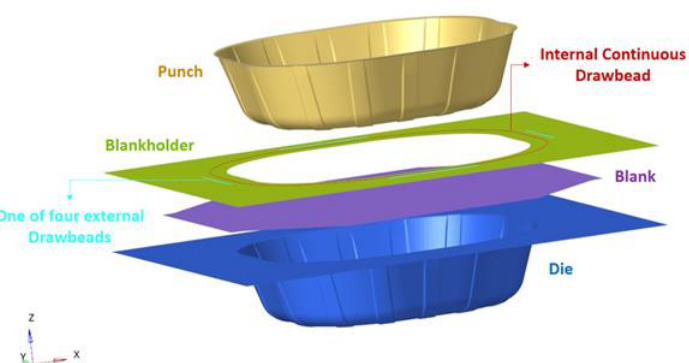
Figure 1. Finite element (FE) model created for simulation of the sheet forming process.